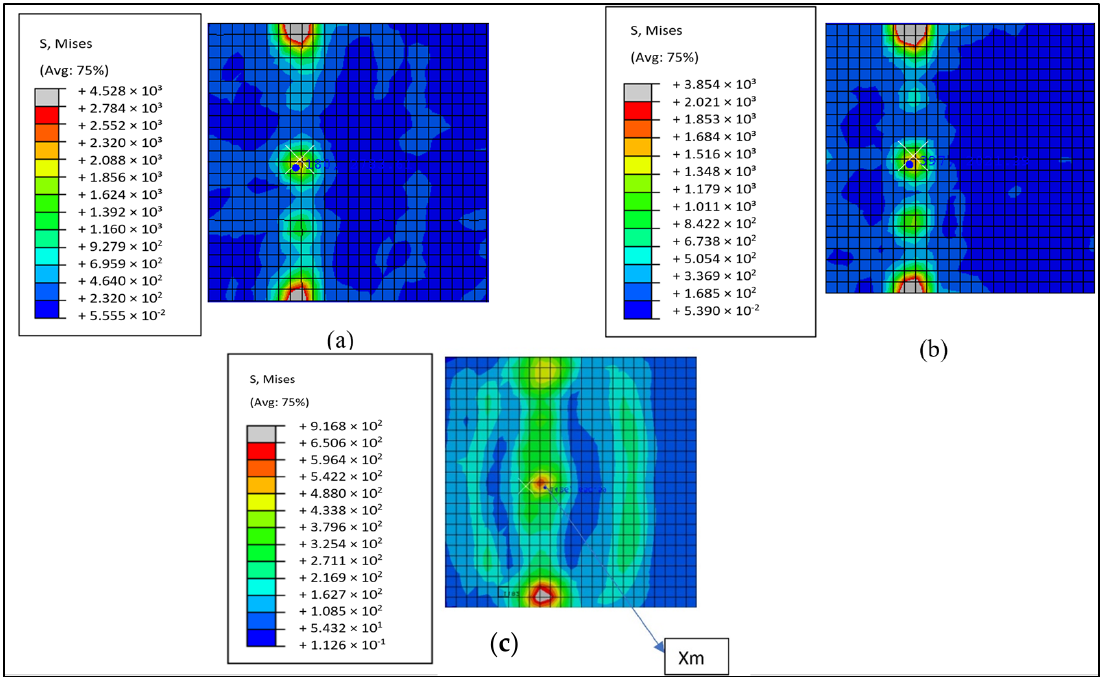
Figure 12. Von-Mises stress contour at the top of the polycarbonate covers for ( a ) SP10, ( b ) SP16, and ( c ) in the middle section of the typical pavement model after 2.250 s into the simulation.